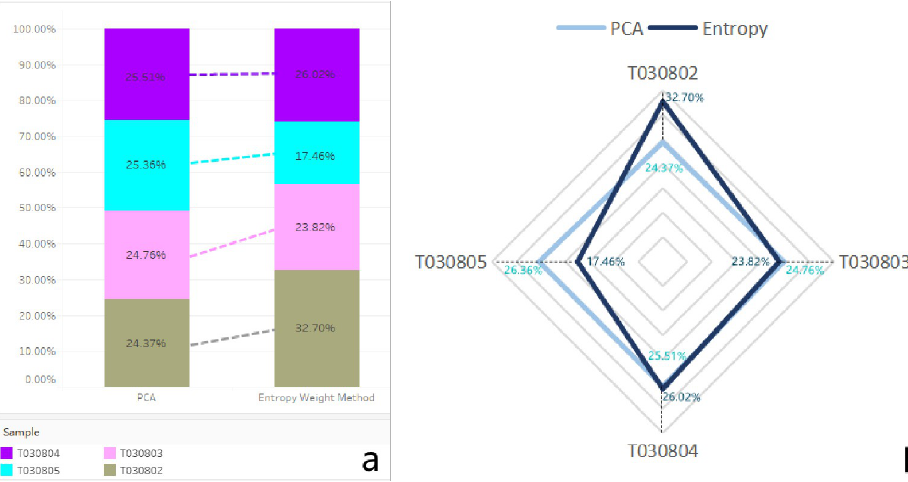
Fig 5. Visualization of comparison of the weighted index in Case Study